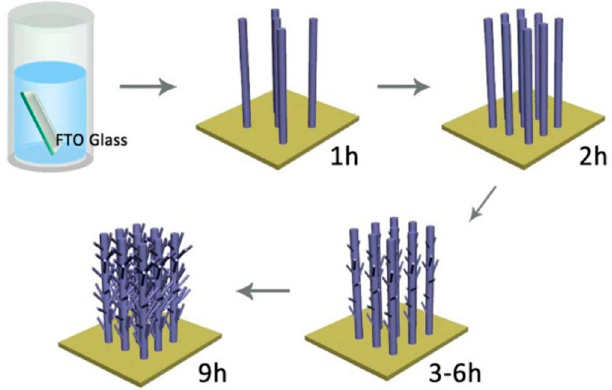
Figure 5. Schematic of formation process of hierarchical TiO 2 nanostructures. Reproduced from 354 Reference [97] under the Creative Commons CC-BY-NC-ND license.